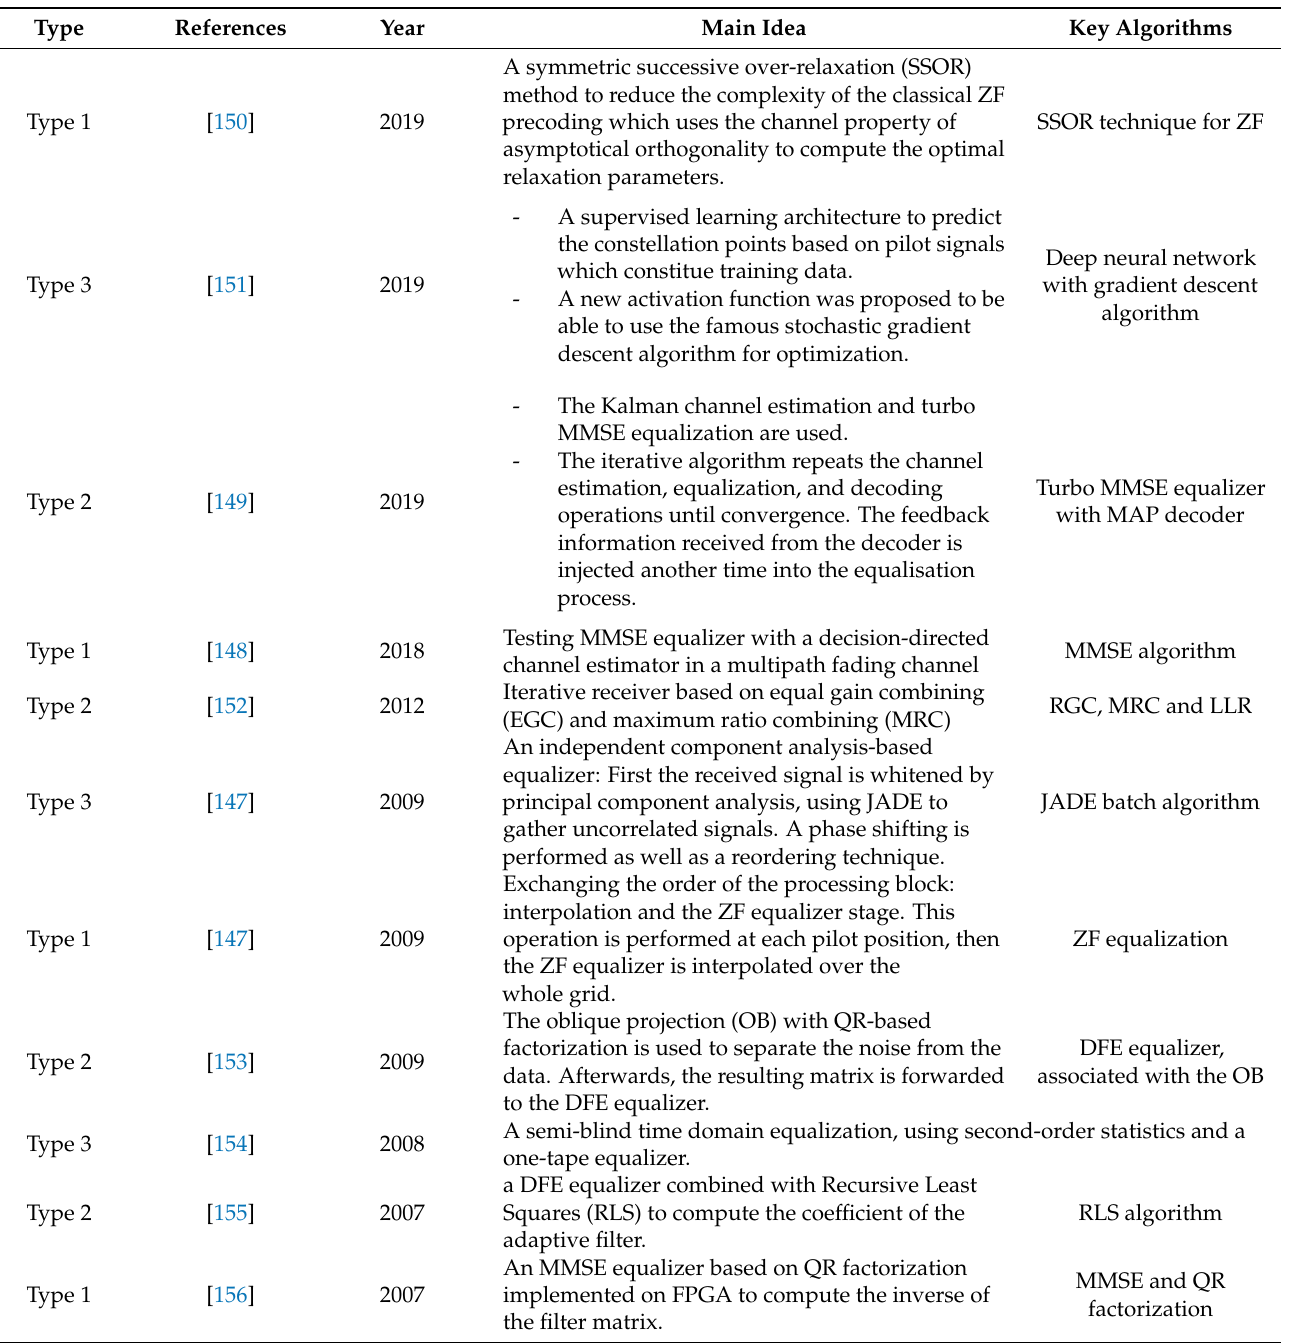
Table 7. MIMO-OFDM equalization algorithm